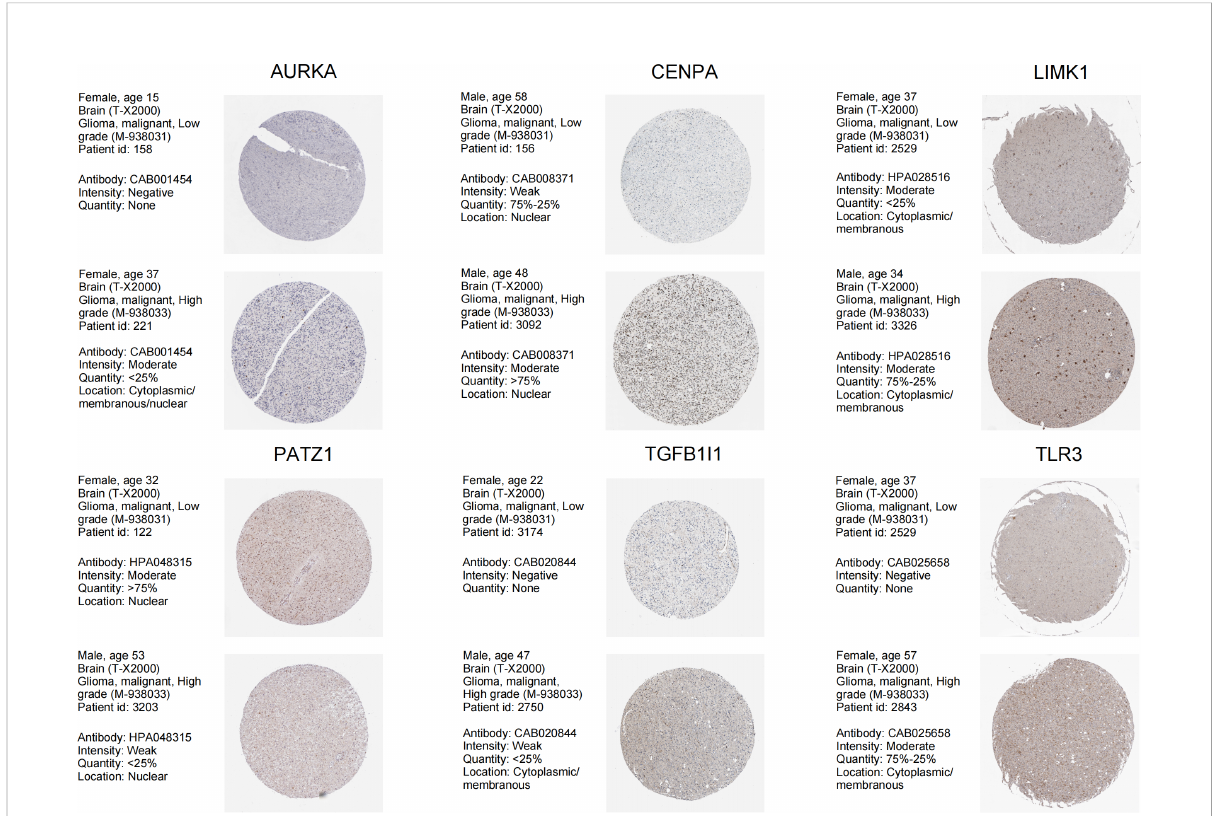
FIGURE 3 Immunohistochemical analyses from HPA database of the 6 SnGs in LGG and HGG, including AURKA, CENPA, LIMK1, PATZ1, TGFB1I1, and TLR3.